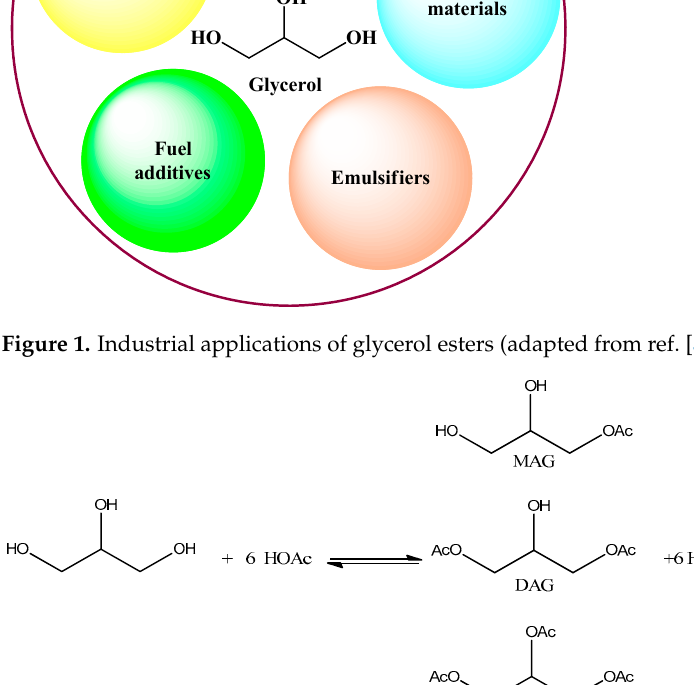
Figure 1. Industrial applications of glycerol esters (adapted from ref.